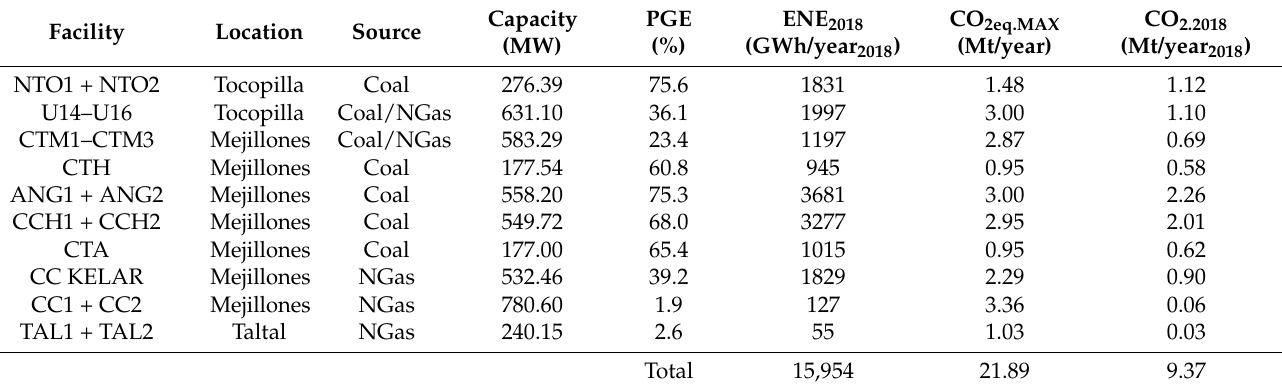
Table 7. Distribution, capacity, efficiency (PGE), and CO 2 to be sequestered of thermoelectric plants greater than 100 MW in Antofagasta region. NGas: natural gas; ANG1, ANG2: Angamos thermoelectric power plants; CC KELAR: Kelar thermoelectric power plant; CCH1, CCH2: Cochrane thermoelectric power plants; CC1, CC2: Atacama thermoelectric power plants; CTA: Andina thermoelectric power plant; CTH: Hornitos thermoelectric power plant; CTM1–3: Mejillones thermoelectric power plants; NTO1, NTO2: Norgener thermoelectric power plants; TAL1, TAL2: Taltal thermoelectric power plants; U14–16: Tocopilla thermoelectric power